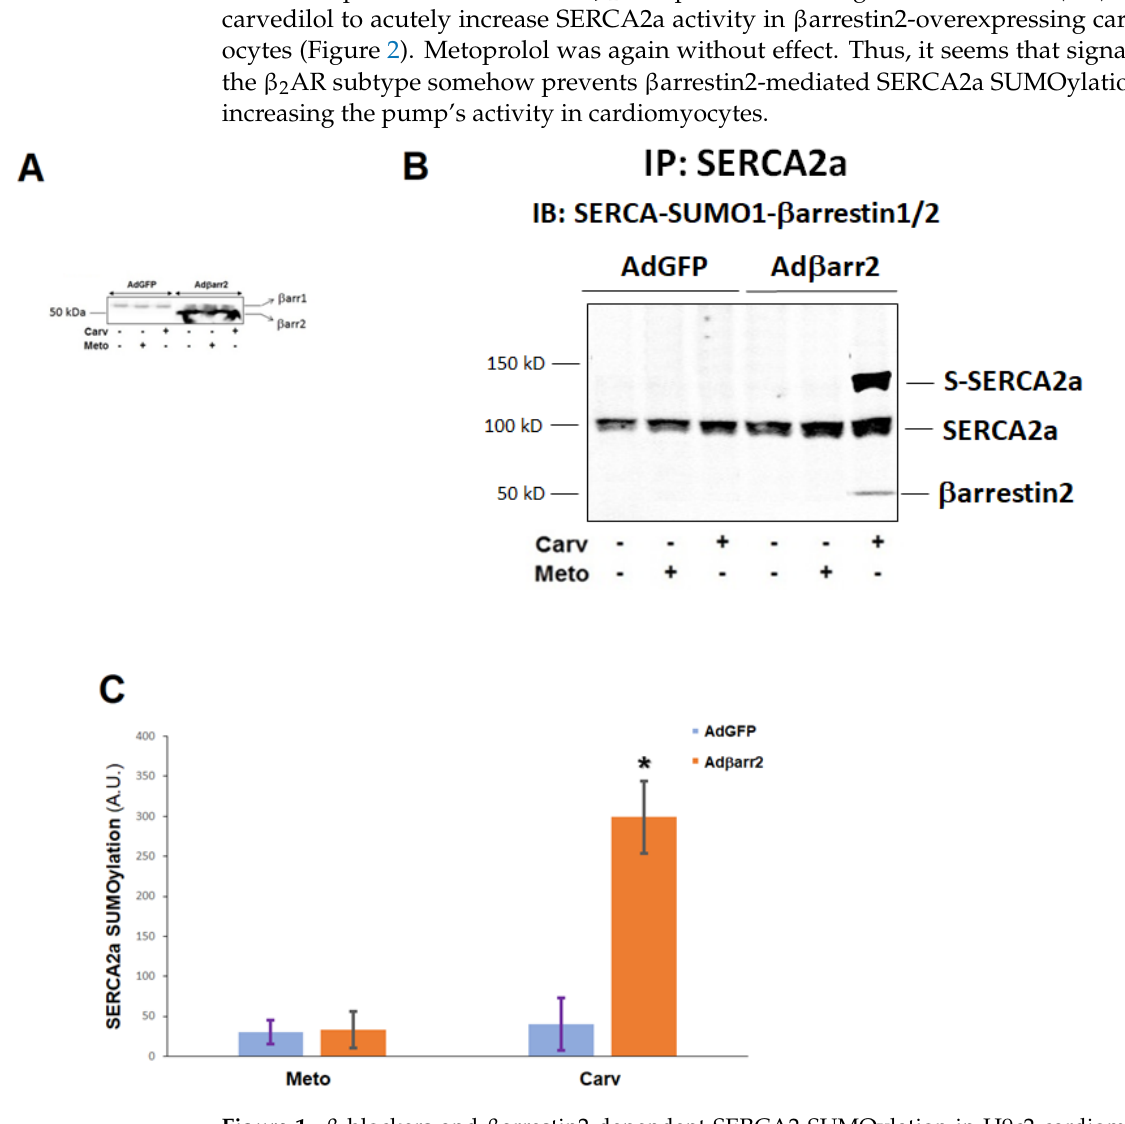
Figure 1. β -blockers and β arrestin2-dependent SERCA2 SUMOylation in H9c2 cardiomyocytes. ( A ) Immunoblotting for β arrestins in control (infected with adenovirus encoding for green fluorescent protein, AdGFP) or in H9c2 cardiomyocytes infected with adenovirus encoding for β arrestin2 (Ad β arr2) to confirm β arrestin2 overexpression in the latter cells. H9c2 cardiomyocytes express only β arrestin1 ( β arr1) endogenously at detectable levels (see AdGFP lanes and Refs. [7,20]). Shown is a representative blot of three independent experiments. ( B , C ) Immunoblotting for β arrestins, SUMO-1 and SERCA2a in SERCA2a immunoprecipitates (IPs) prepared from these cells and treated with vehicle (0.1% DMSO), 1 µ M carvedilol (Carv), or 1 µ M metoprolol (Meto) for 20 min. Representative blots are shown in ( B ) and SERCA2a SUMOylation quantitation, as measured by densitometry, is shown in ( C ). IB: Immunoblotting; IP: Immunoprecipitation; S-SERCA2a: SUMOylated SERCA2a; A.U.: Arbitrary (densitometric) units. Only β arrestin2 (not β arrestin1) could be detected in the SERCA2a IPs and only in Ad β arr2-infected cells treated with carvedilol. * , p < 0.05, vs. any other treatment/cell clone; n = 3 independent experiments.